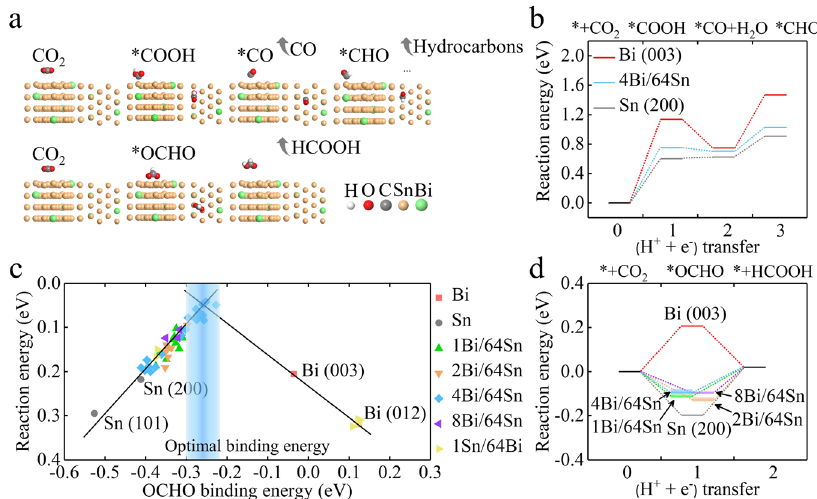
Fig. 2 DFT calculations. a Possible pathways of electrochemical CO 2 reduction. The top panel shows the *COOH pathway to produce CO, CH 4 , or C 2 + hydrocarbons. The bottom panel shows the *OCHO pathway to produce HCOO – . Bi, Sn, C, O, and H atoms are represented by green, yellow, grey, red, and white spheres, respectively. b Reaction energy for CO formation on Bi (003), Sn (200), and Bi 4 Sn 64 (200) surfaces without applying any external potential ( U = 0 eV). c The volcano plot describing *OCHO adsorption energy versus CO 2 -to-HCOO – reaction energy. d Reaction energy for HCOO – formation on Bi (003), Sn (200), and Bi y Sn 64 ( y = 1, 2, 4, 8) surfaces without applying any external potential ( U = 0